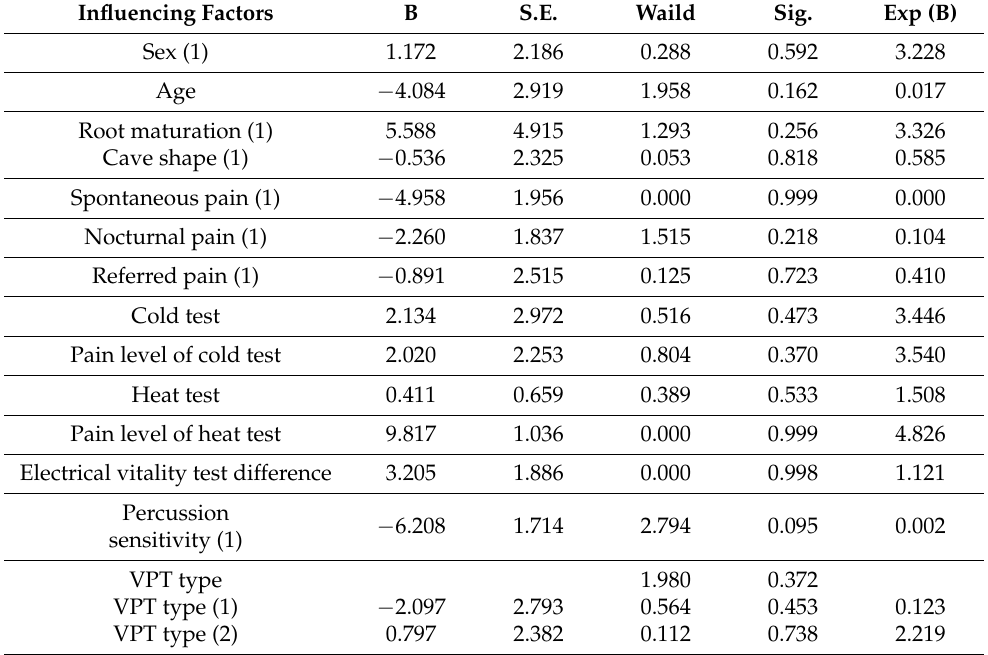
Table 2. Results of regression model